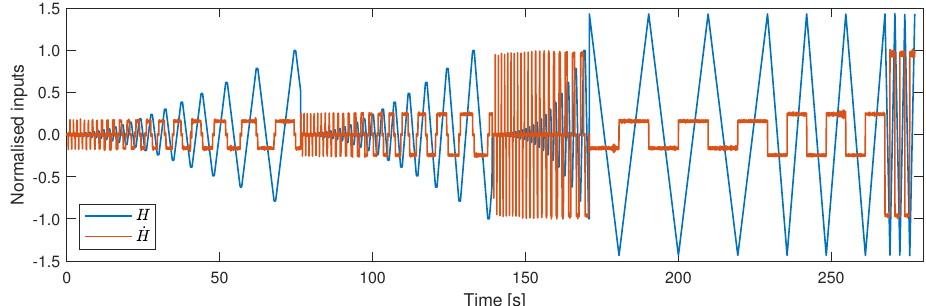
Figure 5. Magnetic field data and its derivative used for training, validation and testing the model.